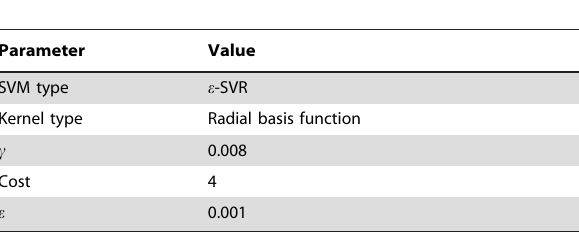
Table 2. Optimal runtime parameters for the SVM Model.